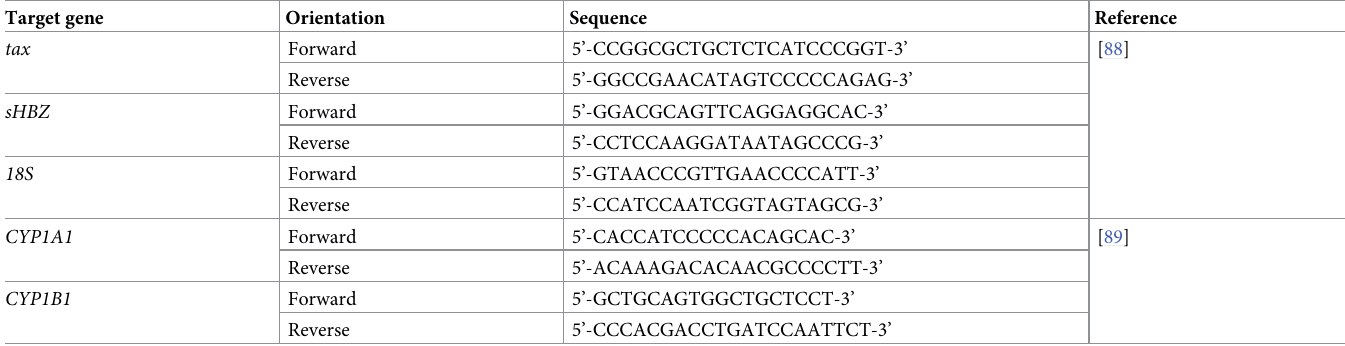
Table 3. Gene-specific primers used for